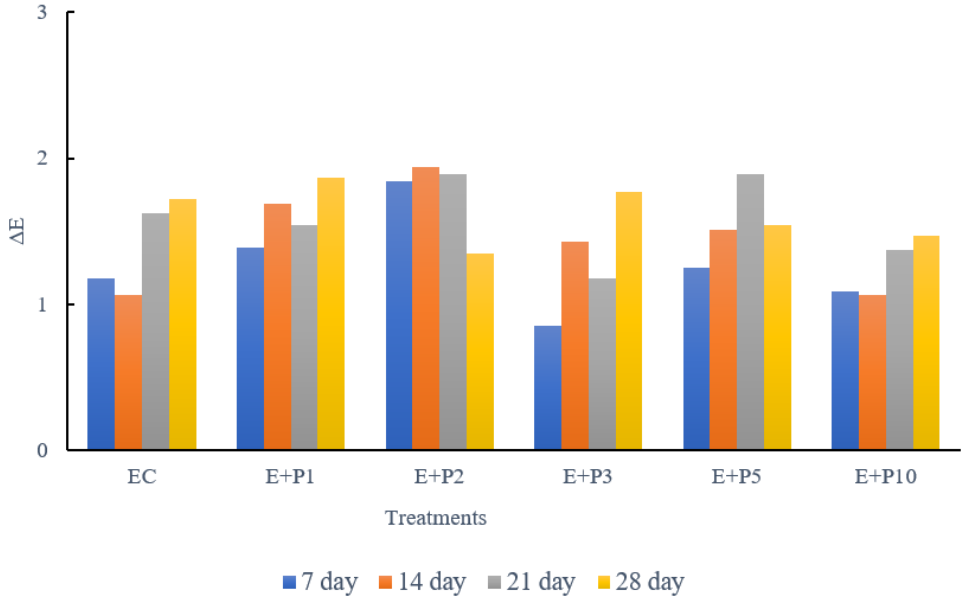
Figure 3. Changes in the total color difference of hen eggs during 28 storage days. Treatments: EC—control hen eggs, E + P1–E + P10 coated hen eggs with ethanol propolis extract at concentrations of 1 – 10%.